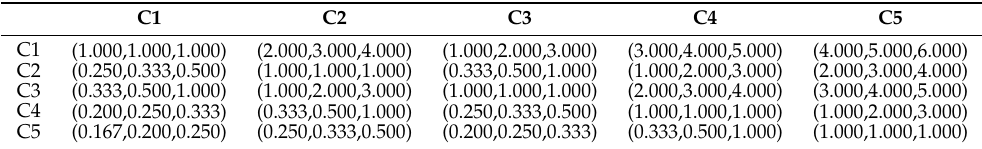
Table 3. Direct comparison matrix in a normal situation (cid:101) C ( k )